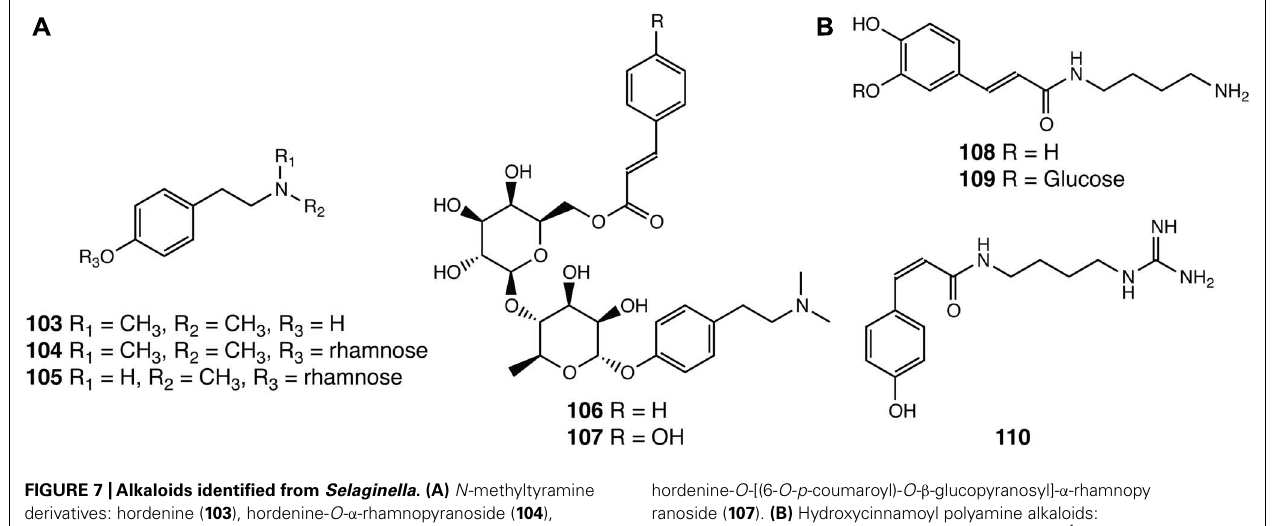
hordenine- O -[(6- O - p -coumaroyl)- O - β -glucopyranosyl]- α -rhamnopy ranoside ( 107 ). (B) Hydroxycinnamoyl polyamine alkaloids: paucine ( 108 ), paucine 3 (cid:2) - β - D -glucopyranoside ( 109 ), N 1 - cis - p -cou maroylagmatine ( 110